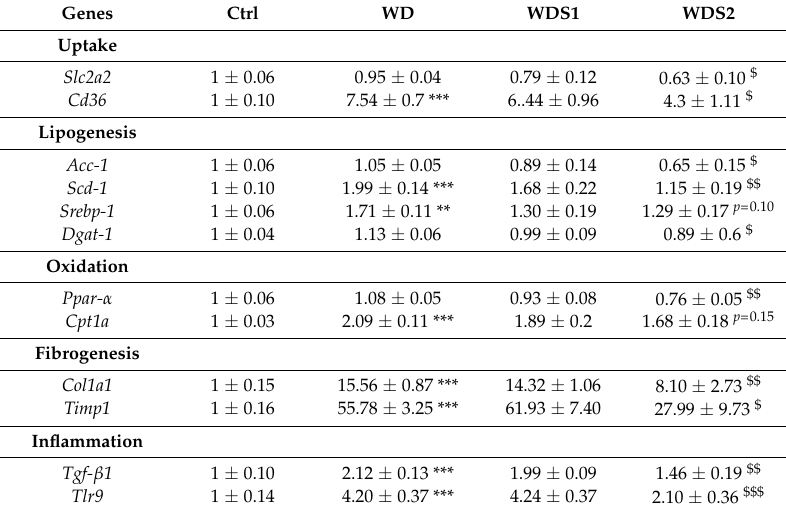
Figure 2. Spirulina alleviates western diet induced hepatic fibrosis and inflammation. ( A ) Liver weight, ( B ) liver weight to body weight ratio, ( C ) plasma aspartate aminotransferase (ASAT) and ( D ) plasma alanine aminotransferase (ALAT) measured at the end of the protocol. ( E ) Whole liver pictures, hematoxylin-eosin-saffron (HES) (Bar = 300 µm) and picrosirius red (Bar = 200 µm) staining images allowing quantification of ( F ) area of steatosis and ( G ) area of fibrosis. * p < 0.05, ** p < 0.01, *** p < 0.001 ( n = 9–10/group), ANOVA. Some key hepatic metabolic genes were analyzed and reported in Table 1. Slc2a2 gene was downregulated in WDS2 in comparison to WD ( − 34%, p < 0.05) as Cd36 ( − 43%, p < 0.05). These mice Table 1. Expression of key metabolic genes involved in non-alcoholic steatohepatitis (NASH). Values are expressed as relative values with the mean of control mice values set at 1. ** p < 0.01, *** p < 0.001 vs. Ctrl and $ p < 0.05, $$ p < 0.01, $$$ p < 0.001 vs. western diet (WD) ( n = 9–10/group). Genes Ctrl